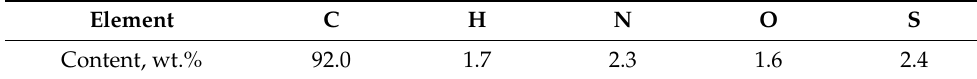
Figure 11. Briquetted underburnt. Table 2. Chemical composition of the underburnt. Iron-containing particles are removed from the mixture by two-stage magnetic separa- tion (Figure 12).